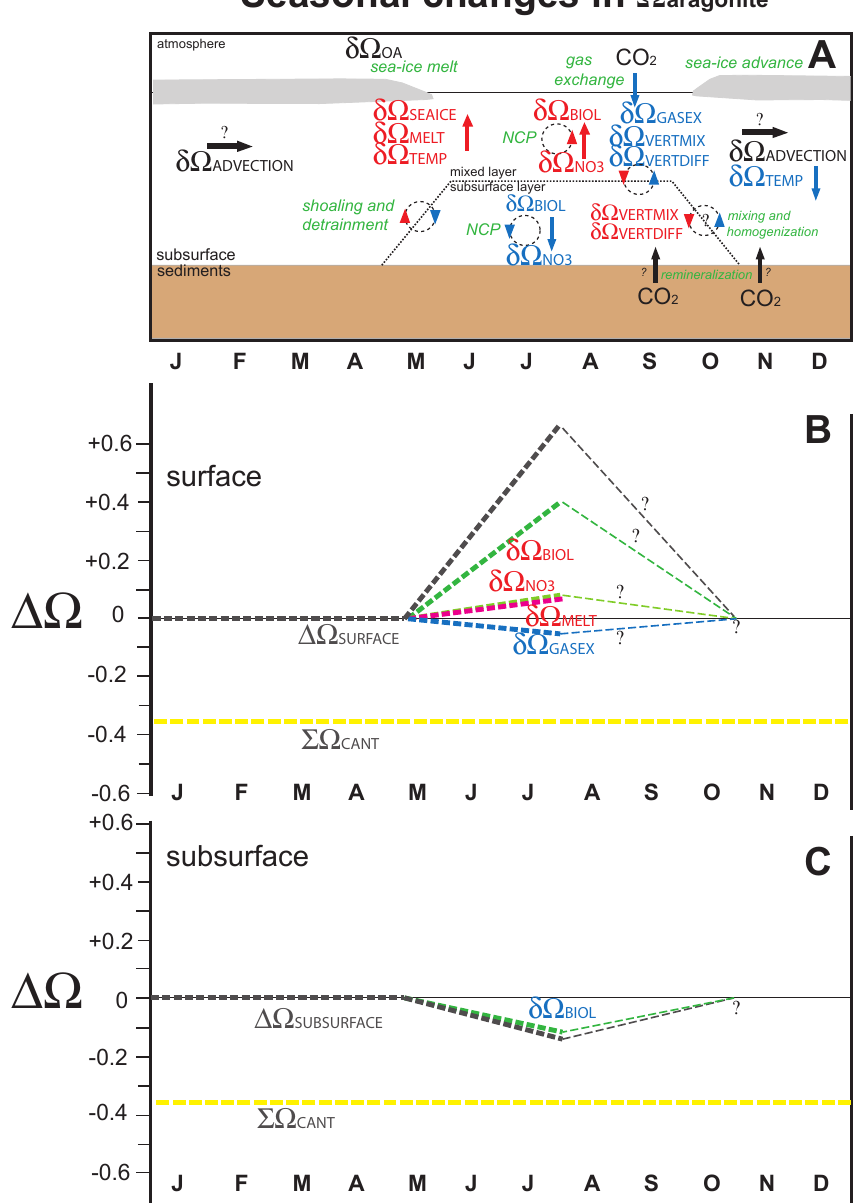
Fig. 10. Conceptual model of seasonal changes in seawater CO 2 -carbonate chemistry on the western Arctic shelves. This hypothesized paradigm shows impact of ocean acidification and biological/physical processes on (cid:127) values for aragonite. It should be stressed that the (cid:127) changes shown reflect “seasonal” changes only (e.g., δ(cid:127) BIOL , δ(cid:127) GASEX , and δ(cid:127) TEMP ) , while 6(cid:127) CANT the cumulative change in (cid:127) due to the emission of anthropogenic CO 2 from pre-industrial times to present (i.e., 6(cid:127) CANT ) is shown for comparison. In all three panels, bottom-axis J to D denotes January to December. The red or blue arrows denote increase or decrease in (cid:127) . (A) Annual schematic of changes in (cid:127) aragonite on shelf waters of the western Arctic Ocean. The sea-ice-free period is approximately 3–4 months. Shelf waters are well mixed during the sea-ice-covered period, with mixed layer developing in late spring due to warming and sea-ice melt, and erosion of the mixed layer in September–October due to convective mixing and homogenization of shelf waters during fall cooling and sea-ice advance. The δ(cid:127) OA , δ(cid:127) BIOL , δ(cid:127) GASEX , and δ(cid:127) TEMP terms are shown in the figure with general direction of forcing of (cid:127) . (B) Annual schematic changes in (cid:127) aragonite of surface waters. The red line denotes total change in (cid:127) (i.e., 1(cid:127) SURFACE ) , while other terms are denoted as follows: 6(cid:127) CANT (yellow), δ(cid:127) BIOL (dark green), δ(cid:127) GASEX (blue), and δ(cid:127) MELT (purple). (C) Annual schematic changes in (cid:127) aragonite of subsurface waters. The red line denotes total change in (cid:127) (i.e., 1(cid:127) SUBSURFACE ) , while other terms are denoted as follows: δ(cid:127) BIOL (dark